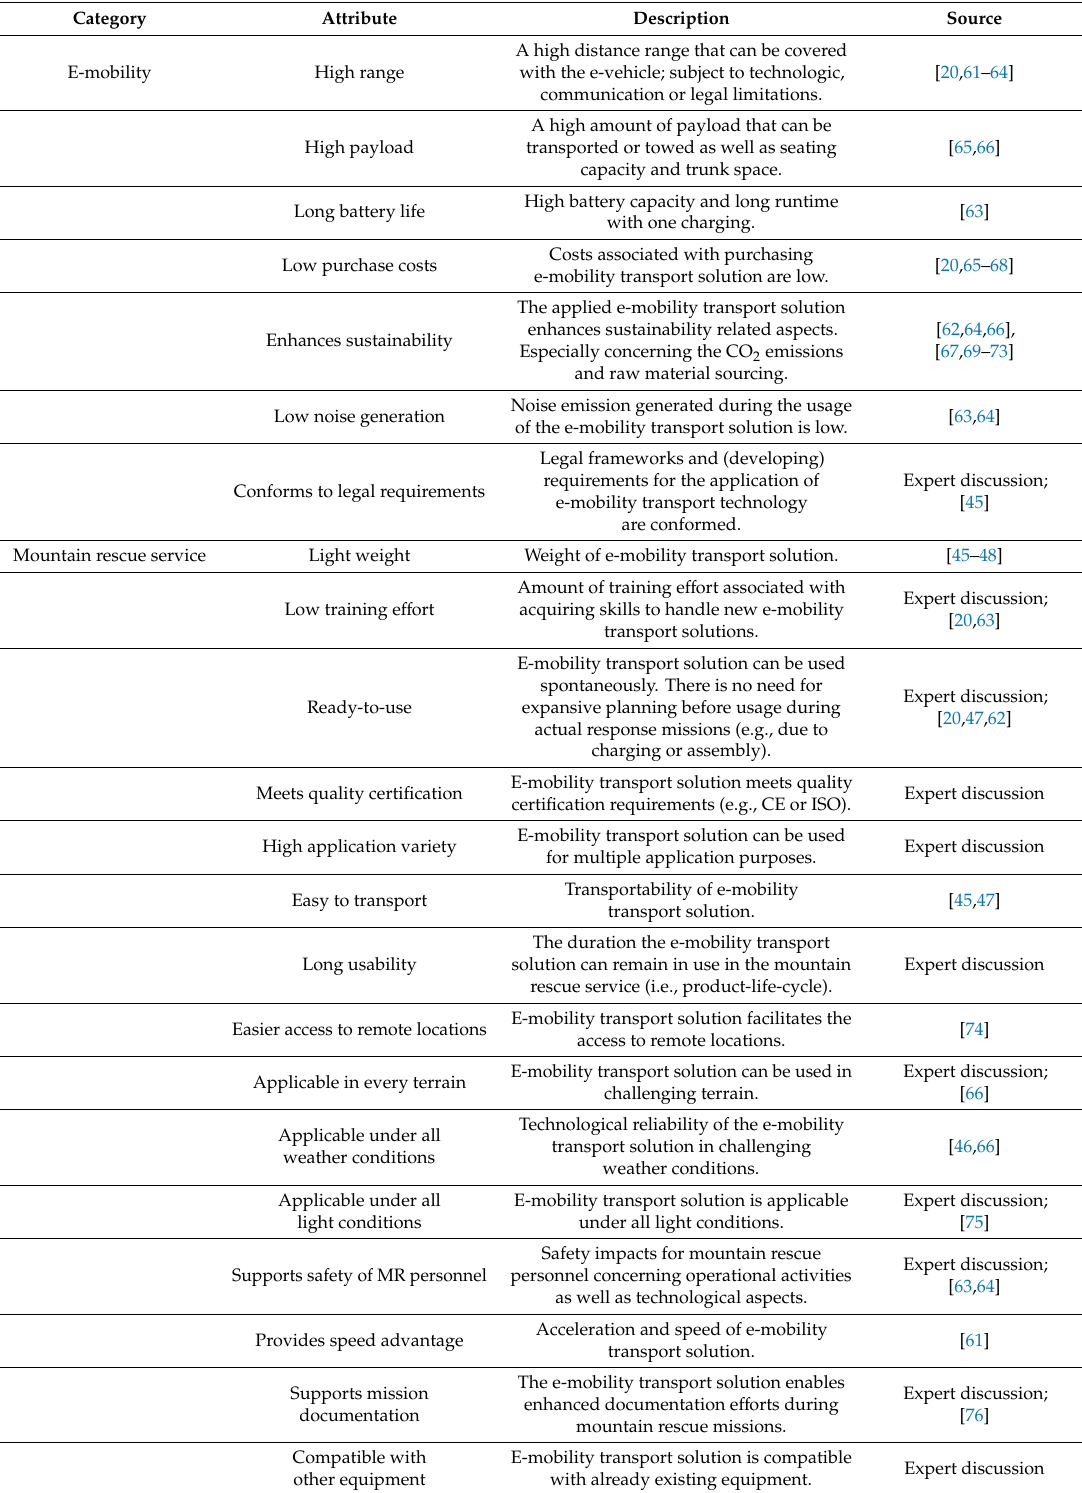
Table 1. Relevant attributes as identified in scientific literature and expert discussion